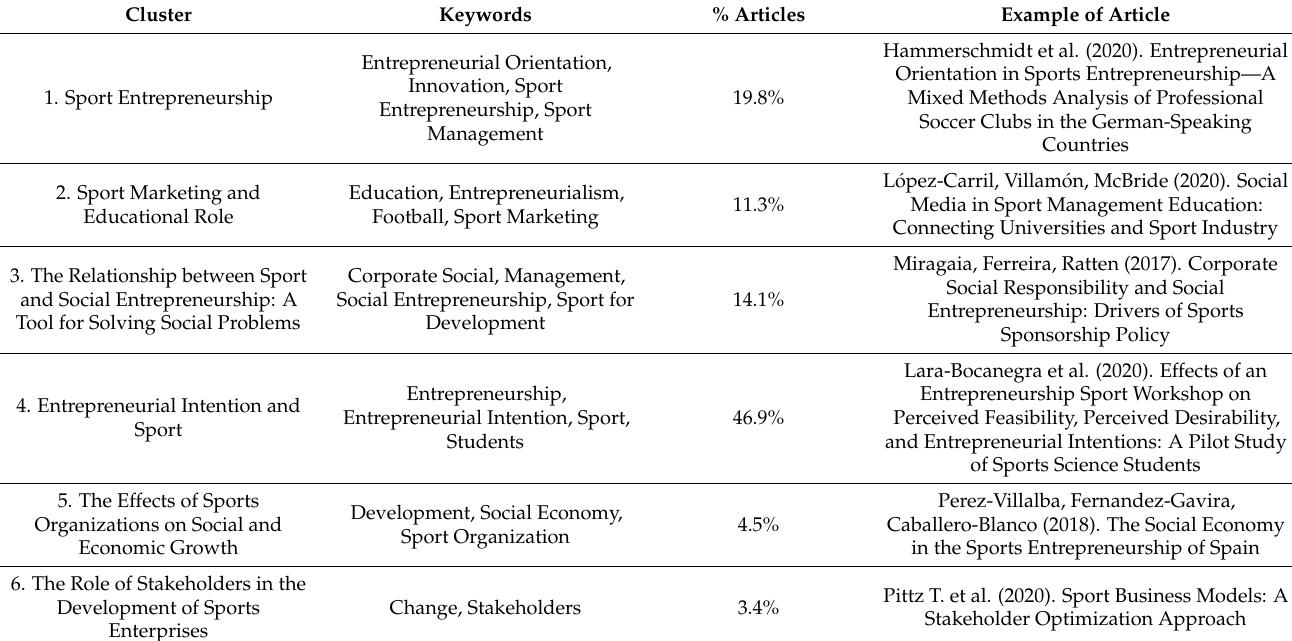
Table 4. Summary of the cluster analysis of the “entrepreneurship” and “sport”